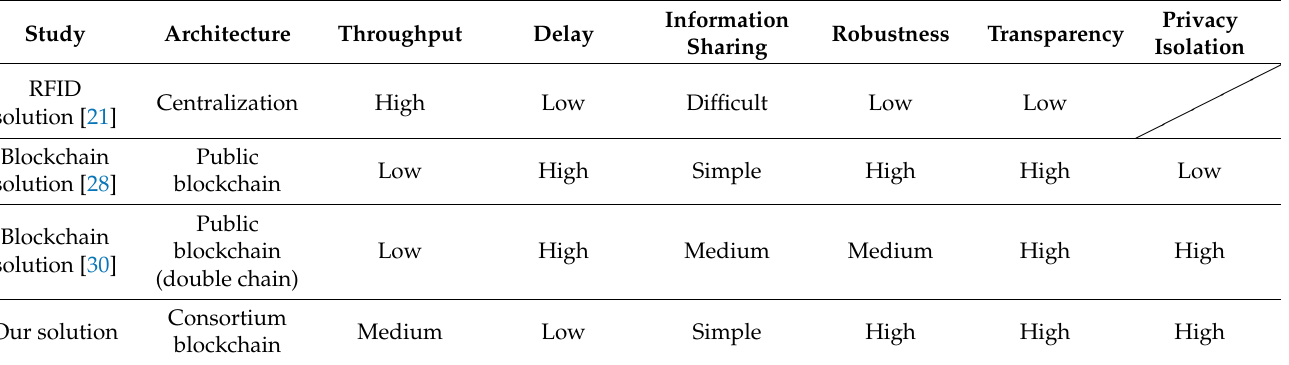
Table 8. Comparison with previous studies.